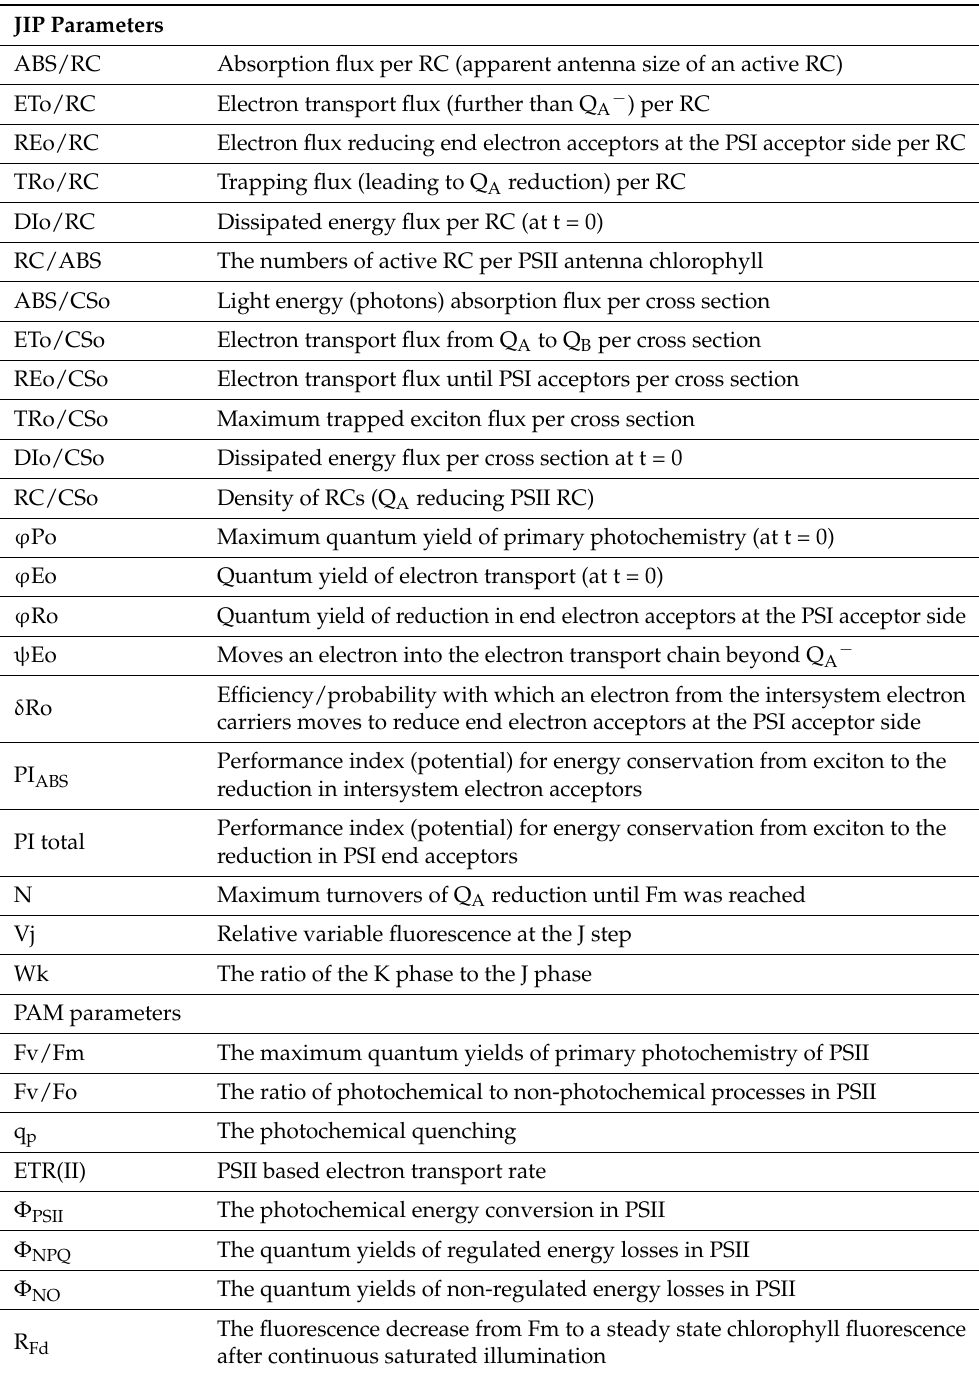
Table 1. Description of the selected parameters of chlorophyll fluorescence, based on information presented in [40–48]. All parameters are in relative